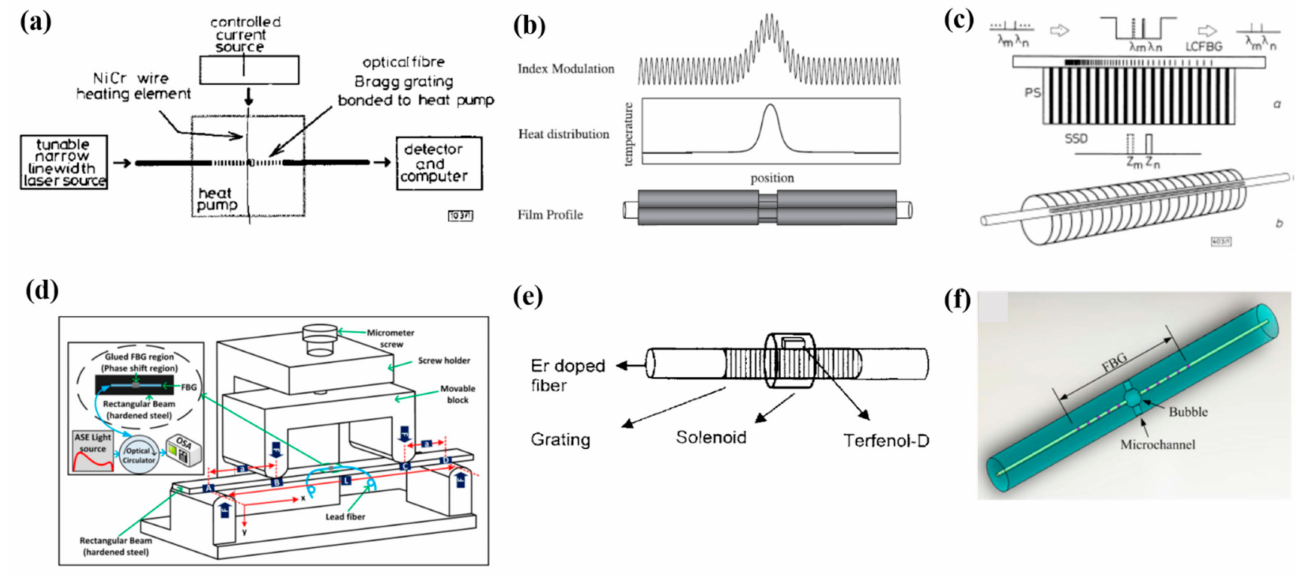
Figure 4. Fabrication methods for insertion of a temporal phase-shift in FBG. ( a ) NiCr wire heating method [23]. ( b ) Thin metal film heating method. Adapted with permission from ref. [27]. ( c ) Piezo- electric transducer method [28]. ( d ) Mechanical pressure method. Adapted with permission from ref. [34]. ( e ) Magnetostrictive transducer technique [35]. ( f ) Femtosecond laser-based